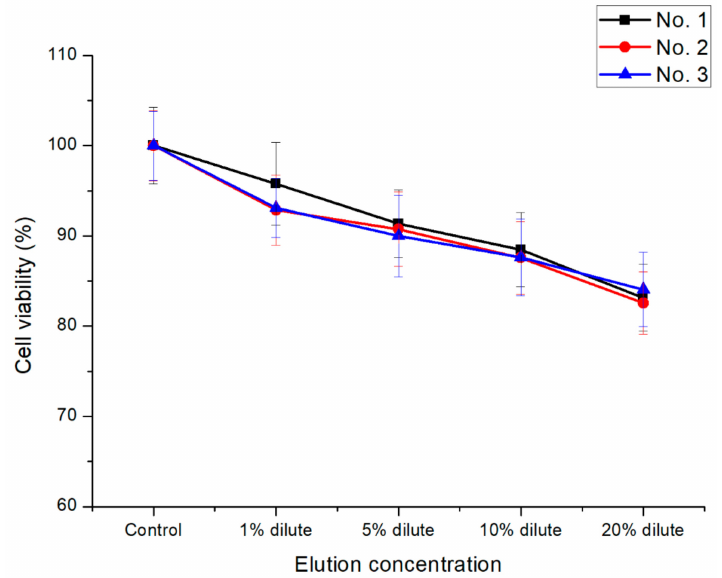
Figure 8. Cell viability results of the P(E2–E4)K composites via the MTT assay. Statistical analysis was conducted by one-way analysis of variance (ANOVA) and Turkey’s test; p < 0.05.